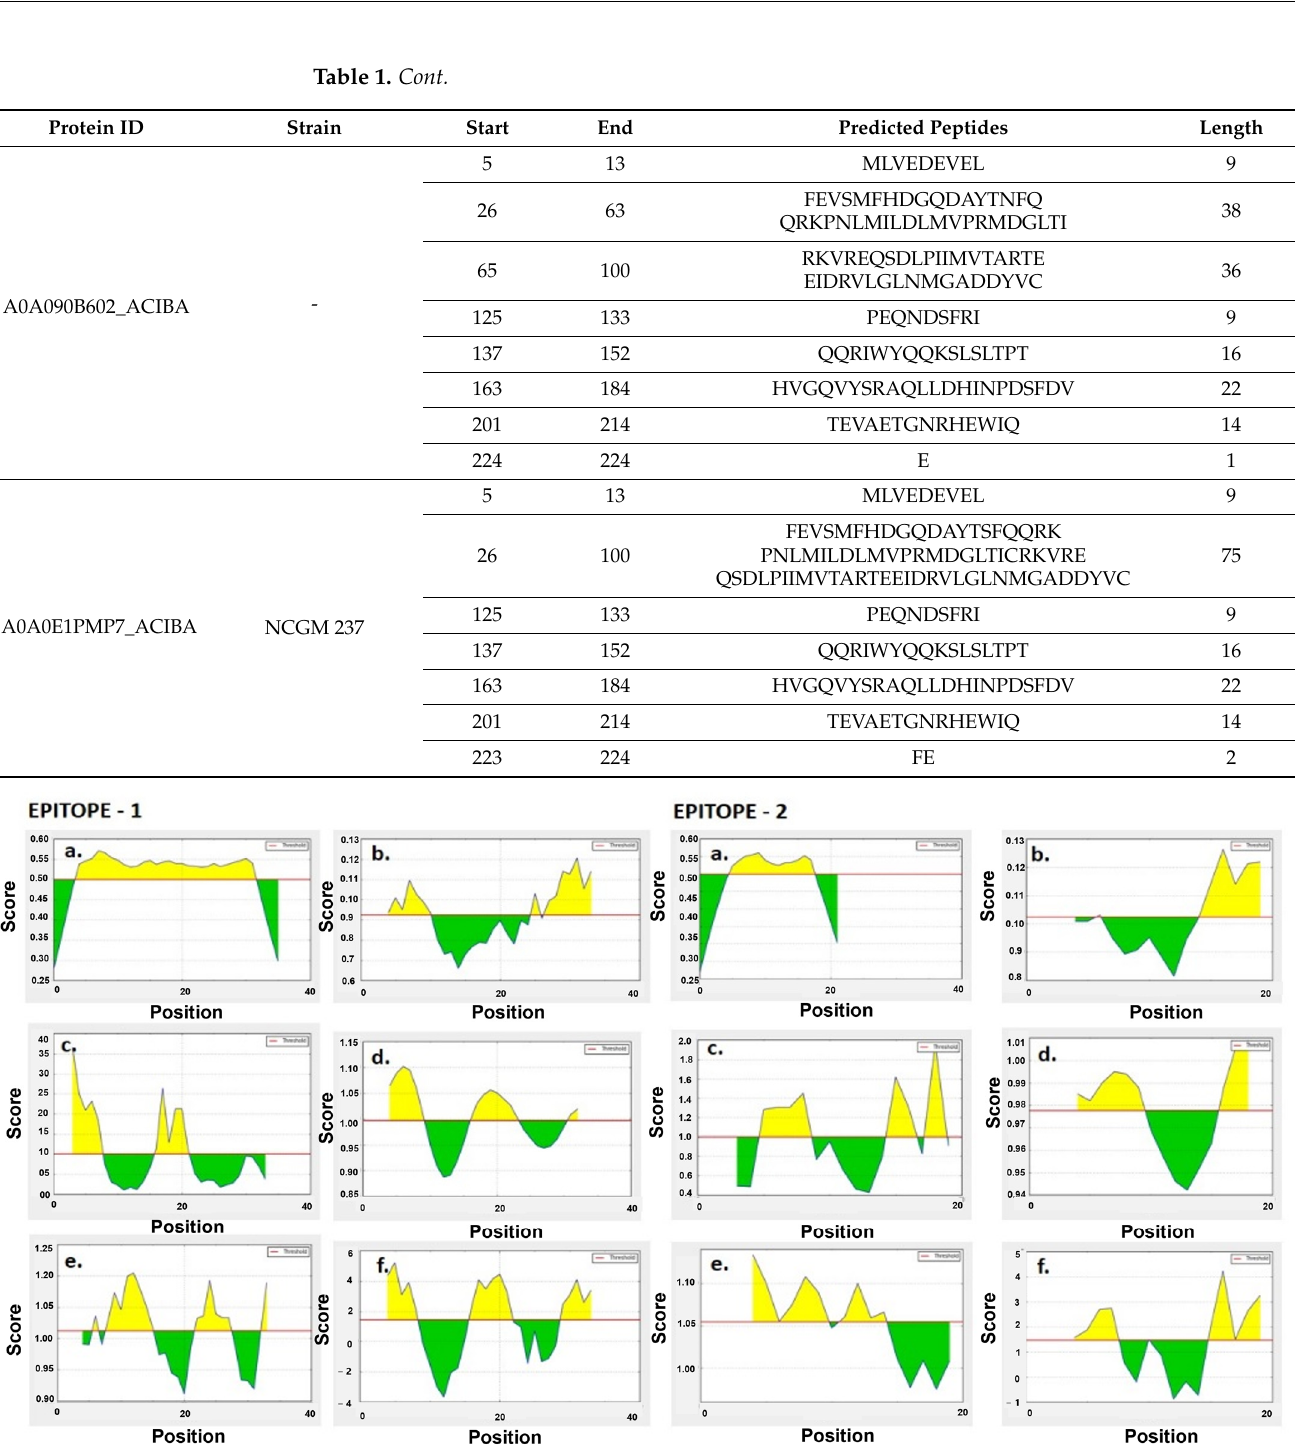
Figure 1. Antigenic predictions of B-cell epitope of BaeR from A. baumannii (epitope 1 and epitope 2); start and end positions of yellow peaks show the sequence of antigenic peptide as determined by ( a ) BepiPred linear epitope predictions, ( b ) Chou–Fasman beta turn assessment, ( c ) Emini surface accessibility predictions, ( d ) Karplus–Schulz flexibility predictions, ( e ) Kolaskar–Tongaonkar antigenicity and ( f ) Parker hydrophilicity